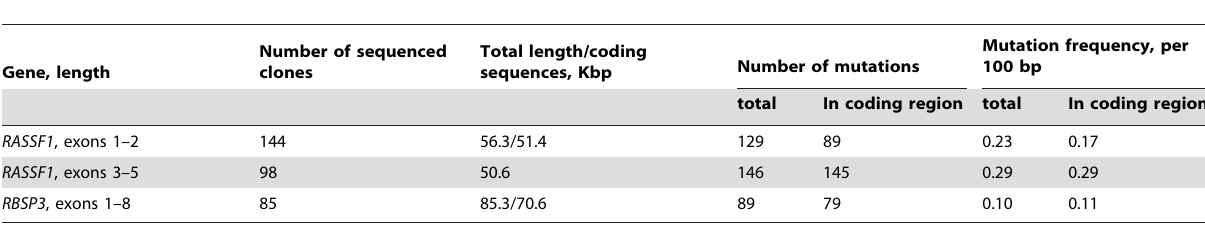
Table 3. Experimental mutations frequency in the RASSF1A and RBSP3 genes.